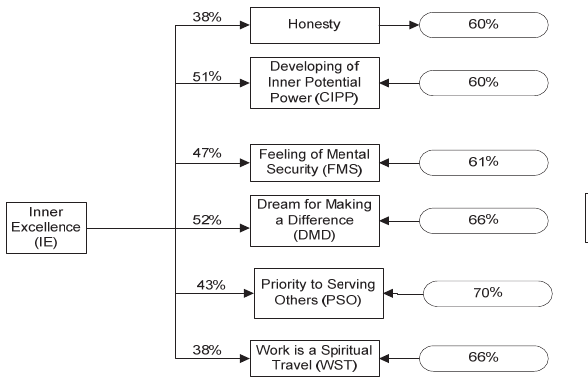
Fig. 5. Factor Analysis Model of hidden variable named Fig. 4. Factor Analysis Model of hidden variable named Spiritual Culture (The fourth indicator of Spirituality and Inner Excellence (The third indicator of Spirituality and Ethics in Higher Education) Ethics in Higher Education)